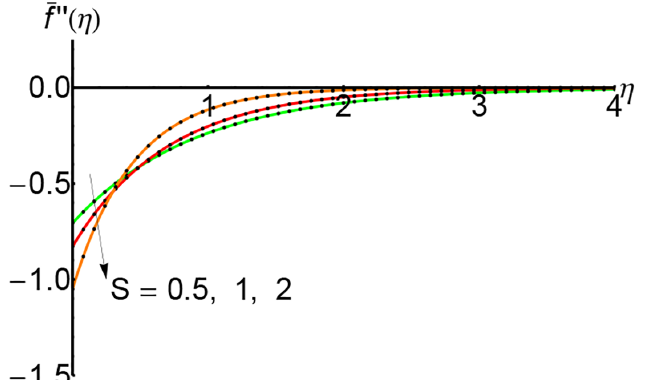
Fig 10. Variation of shear stress (cid:2) f 00 ð Z Þ with η for different values of suction parameter S and for λ = 0.3: —— numerical solution ......... . OHPM solution.